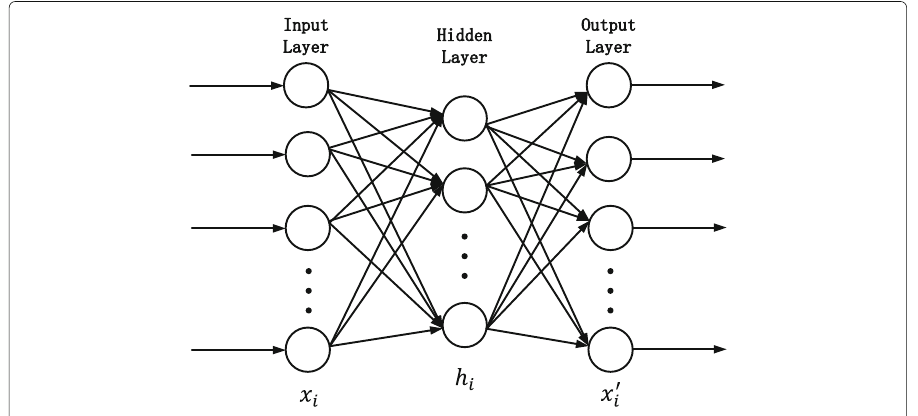
Fig. 3 Structure of the automatic